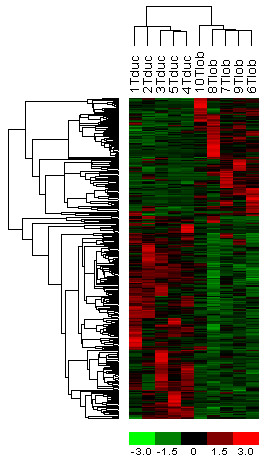
Hierarchical clustering of invasive ductal and lobular breast carcinomas based on 325 probe sets identified by rank products and/or pairwise analysis. Tumor types are well separated. 1–10, case numbers; Tduc, ductal tumor; Tlob, lobular tumor.